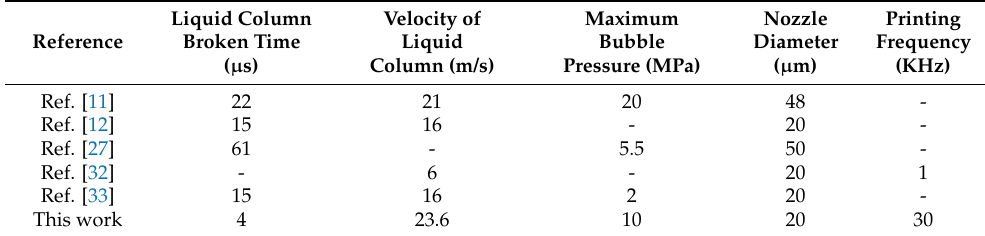
Table 3. Comparison of different shapes of inkjet heads.